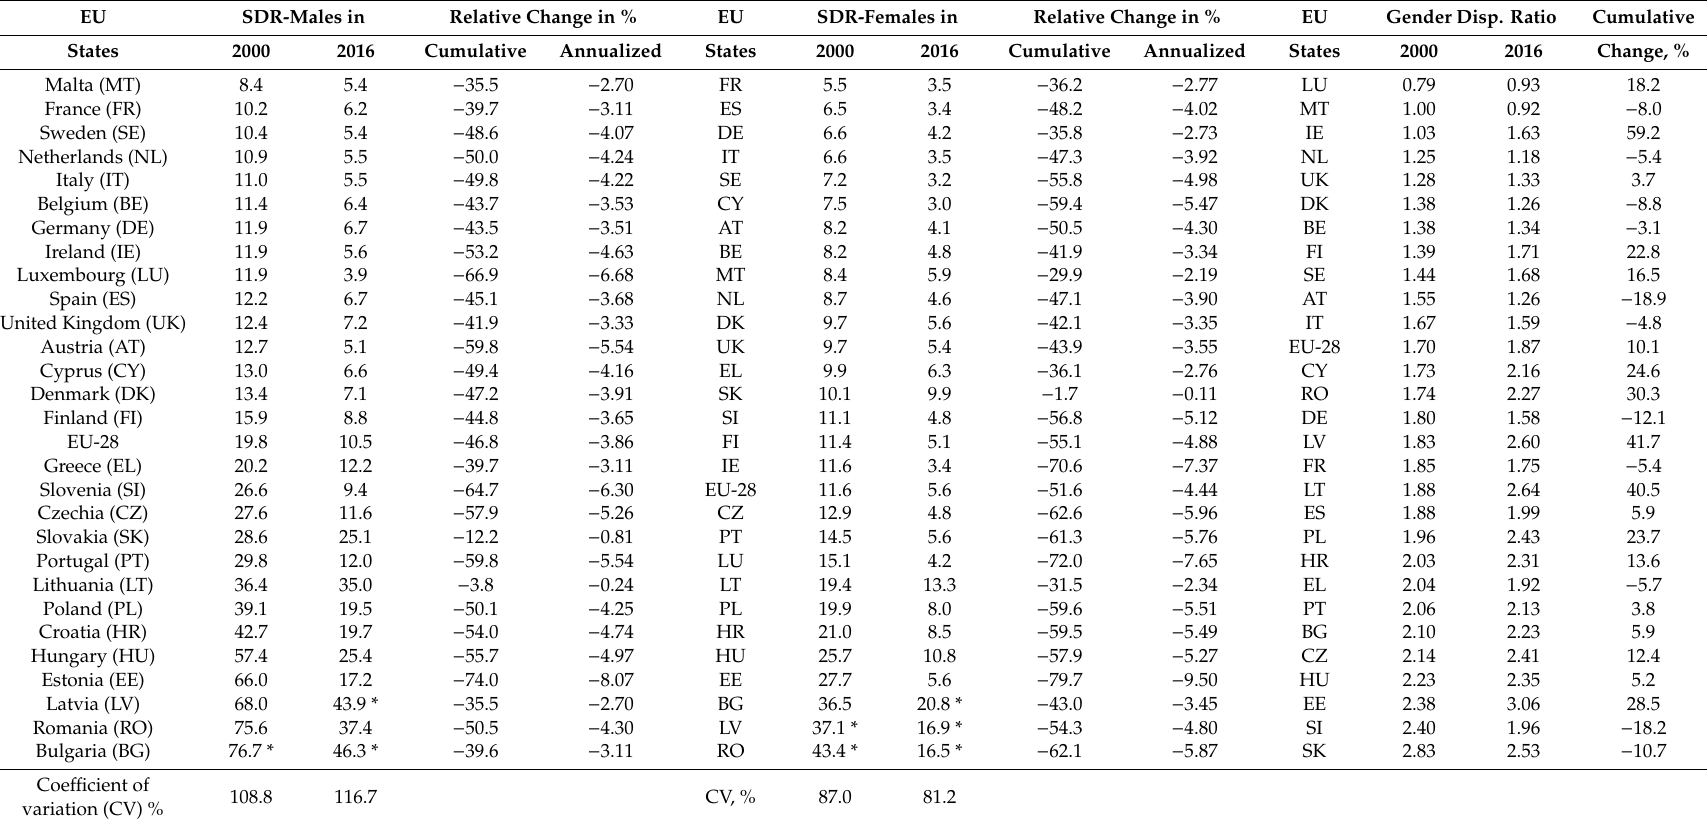
Table 4. Premature SDR for cerebrovascular diseases in the EU countries in 2000 and 2016 1